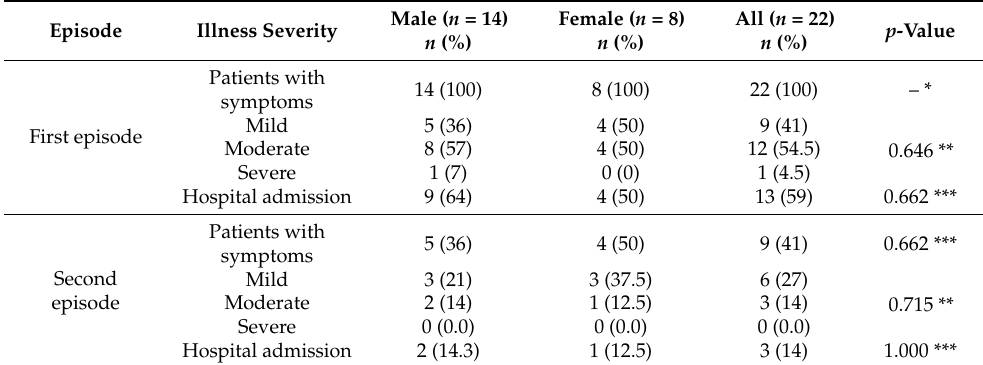
Table 4. Illness severity during the first and second episodes ( n =